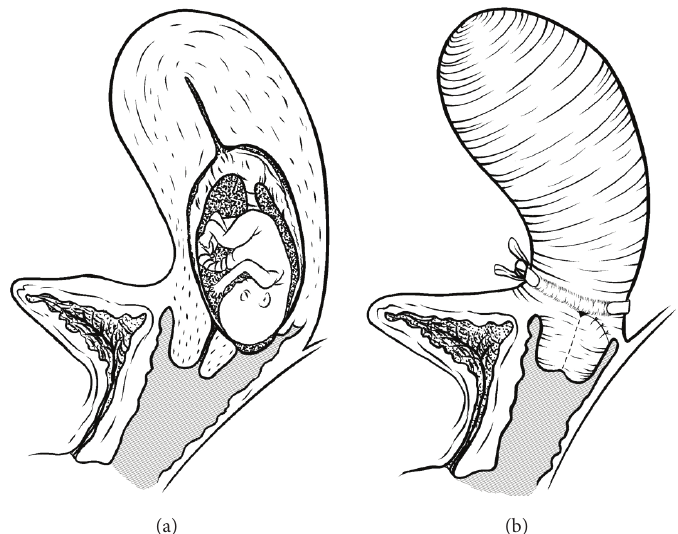
Figure 1: (a) Gestational sac bulging through fistula; (b) sutured fistula and